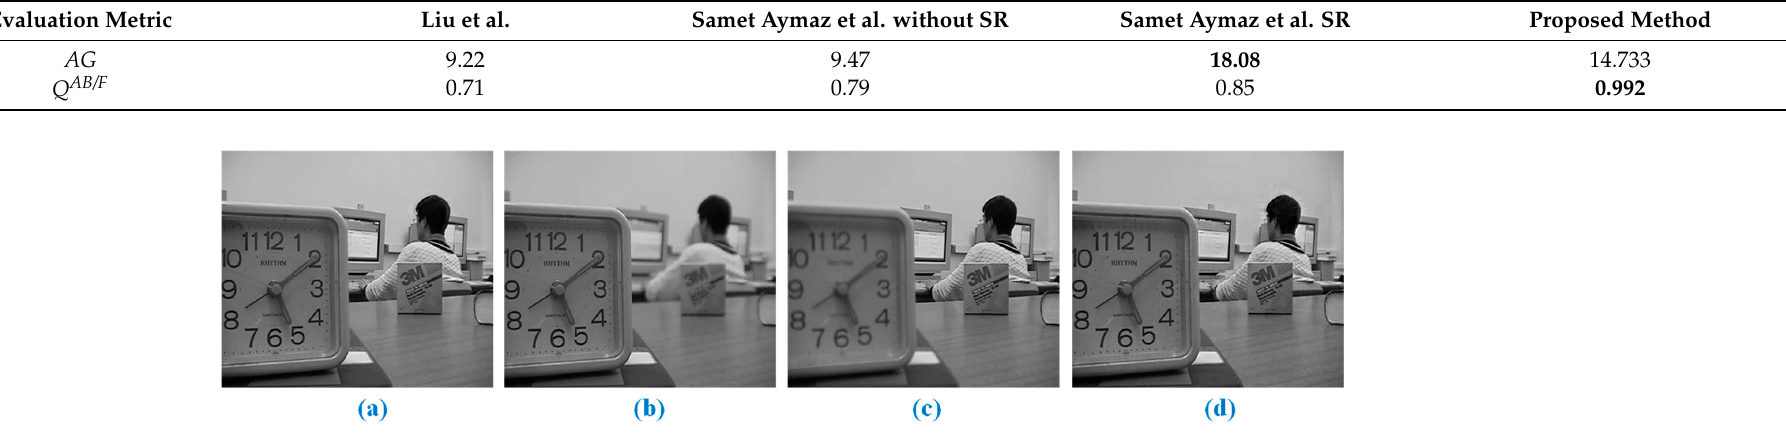
Figure 13. (Lab): ( a ) original image; ( b , c ) multi-focus input images; and ( d ) proposed fusion.